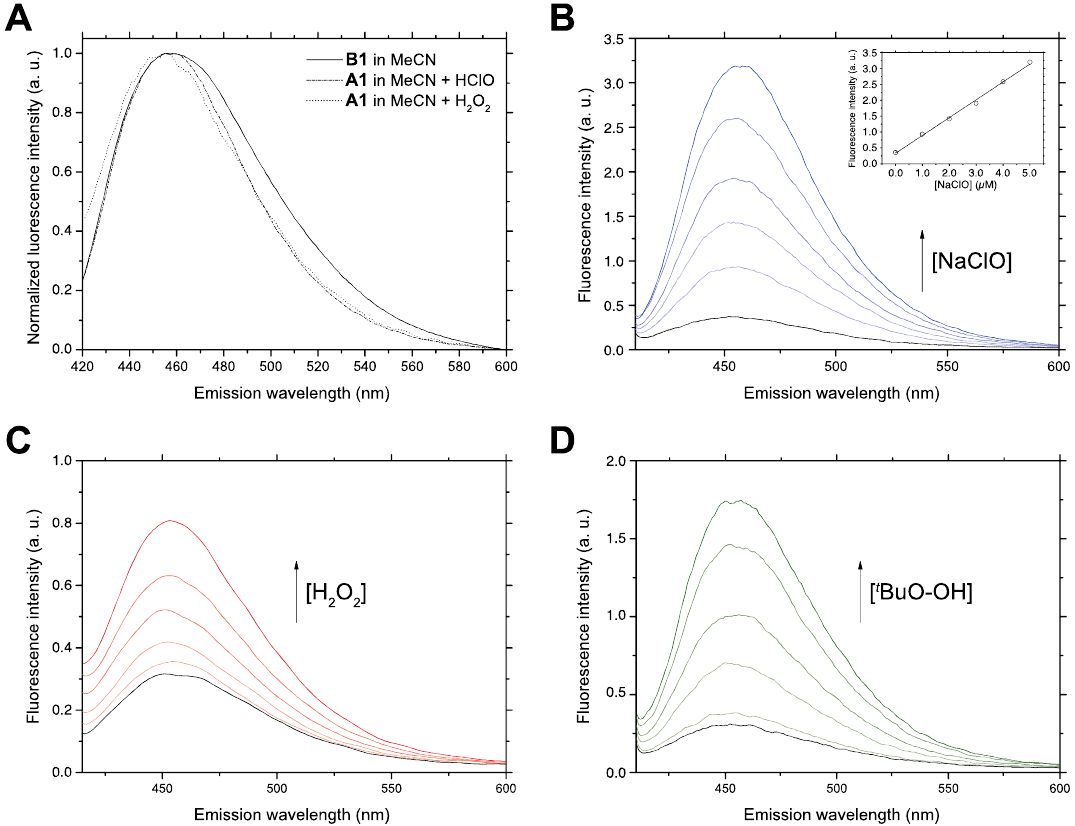
Figure 4. ( A ) Overlaid fluorescence emission spectra (λ ex 360 nm) of synthetic compound B1 and those obtained by oxidation of compound A1 under analytical conditions, i.e., from a reaction medium containing A1 and H 2 O 2 or NaClO in acetonitrile-water (the signals were normalized in order to allow better comparison of the spectral shapes and position of the maxima). ( B ) Fluorescence emission spectra (λ ex 364 nm) of the reaction product of compound A1 with increasing amounts of sodium hypochlorite. Inset: calibration curve corresponding to fluorimetric titration at fixed excitation and emission wavelengths. ( C ) and ( D ) The same experiments performed with hydrogen peroxide and tert -butyl hydroperoxide, respectively. In panels B–D, the trace in black corresponds to the absence of oxidant (c = 0) and the ones corresponding to increasing amounts of antioxidant (c = 1.0 × 10 −6 M, 2.0 × 10 −6 M, 3.0 × 10 −6 M, 4.0 × 10 −6 M and 5.0 × 10 −6 M) are now shown in varying shades of color. In panels B - D , the values of fluorescence intensity in arbitray units (a.u.) should be multiplied by 10 5 .